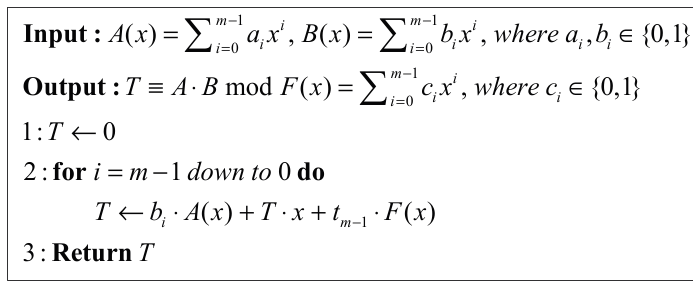
Algorithm 6. Bit-serial multiplication in the field of GF (2 163 ).